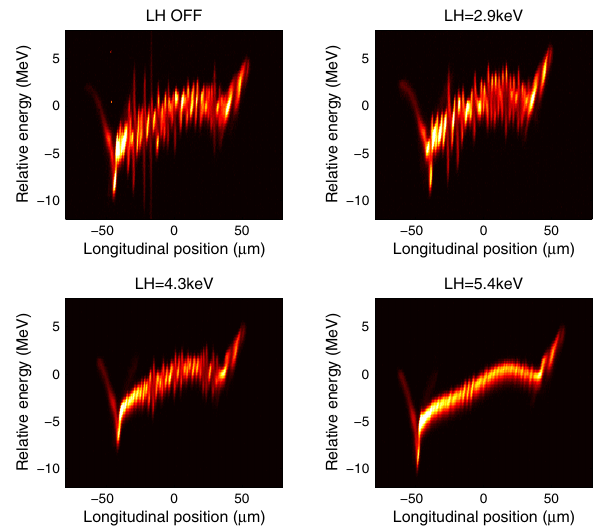
FIG. 2. Measured electron phase space with different rms energy spread induced by the laser heater (LH). Conditions are 0.5 kA peak current, 44 MV XTCAV voltage, and bunch head to the right.